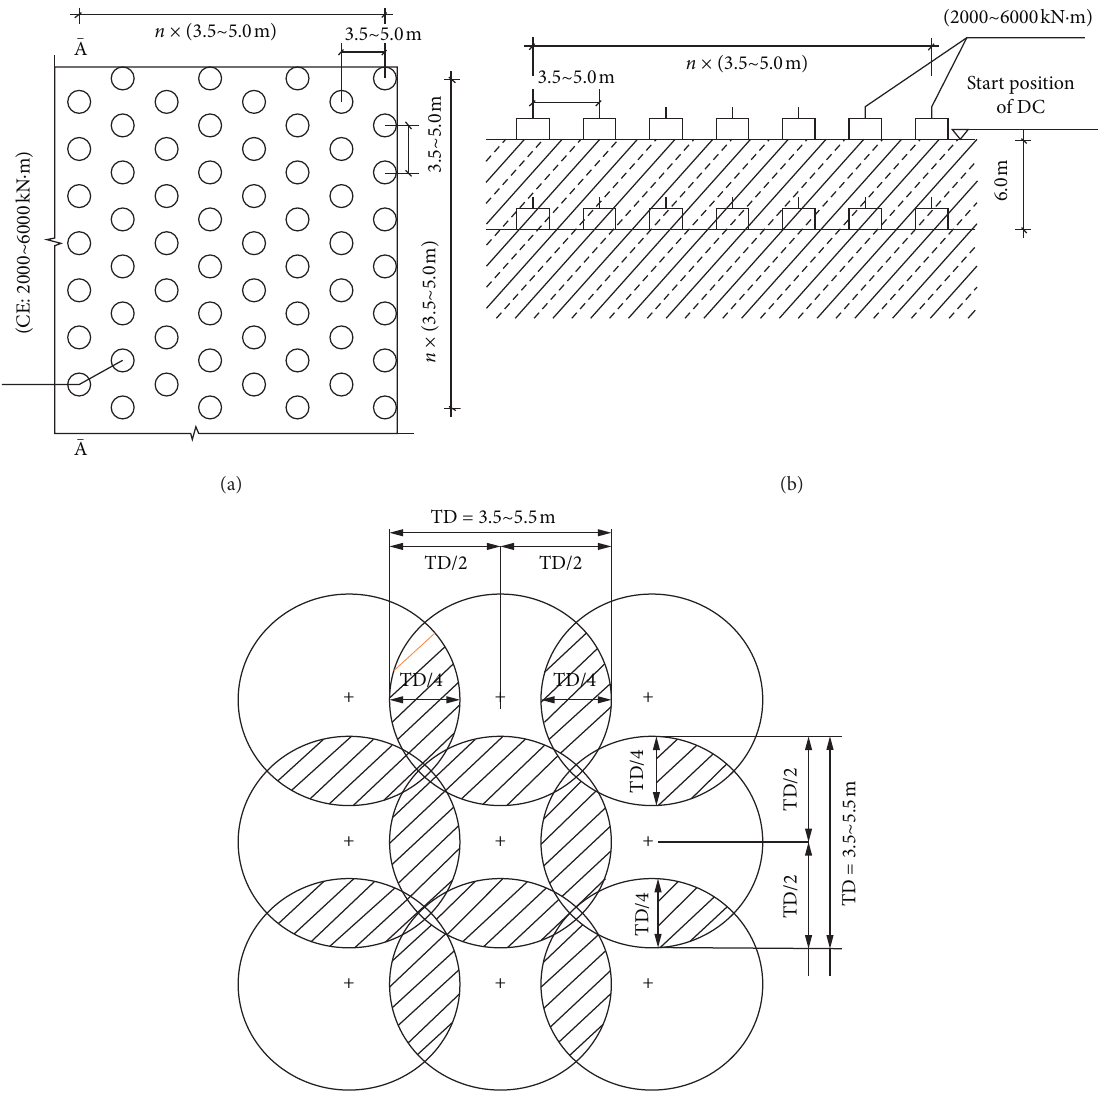
Figure 4: Design scheme for DCs. (a) Plane layout of DCs. (b) A-A section. (c) Overlapping design of overlapping